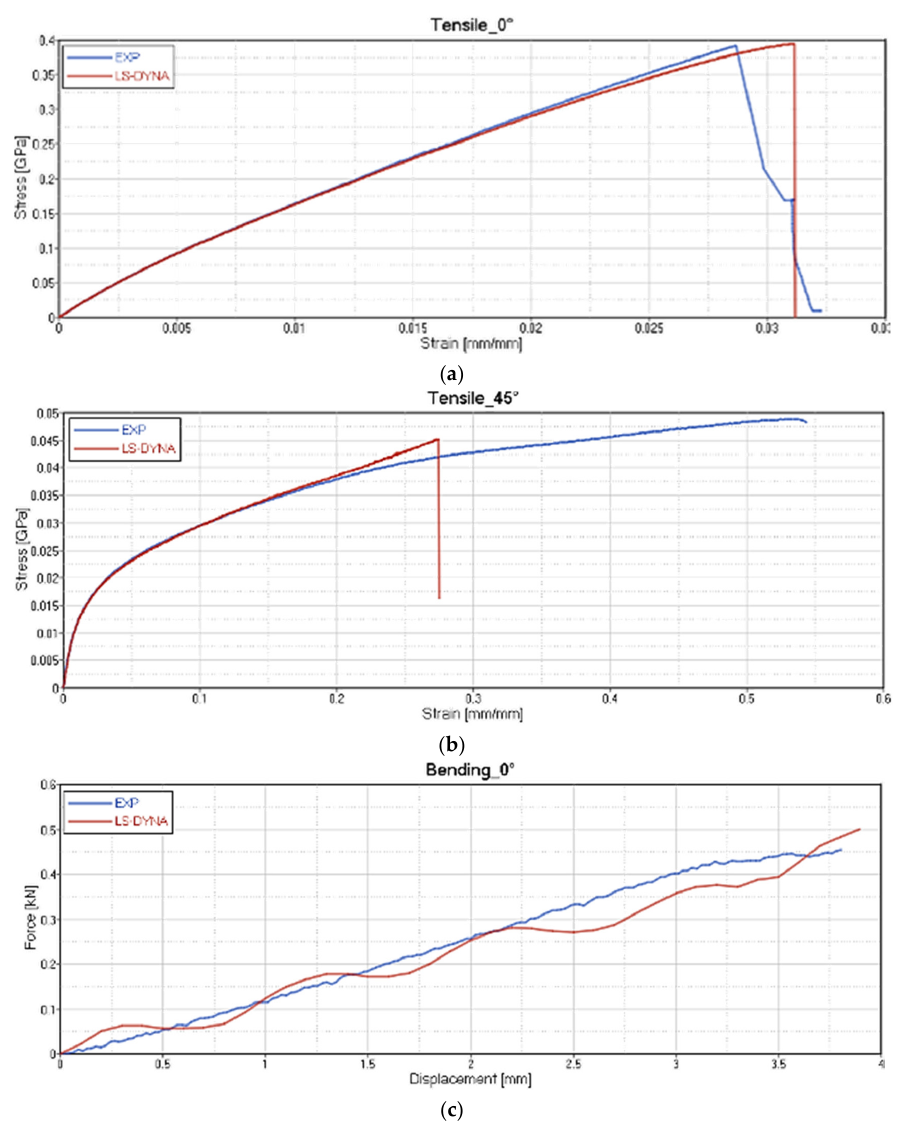
and Bending 0 ◦ test ( c ).